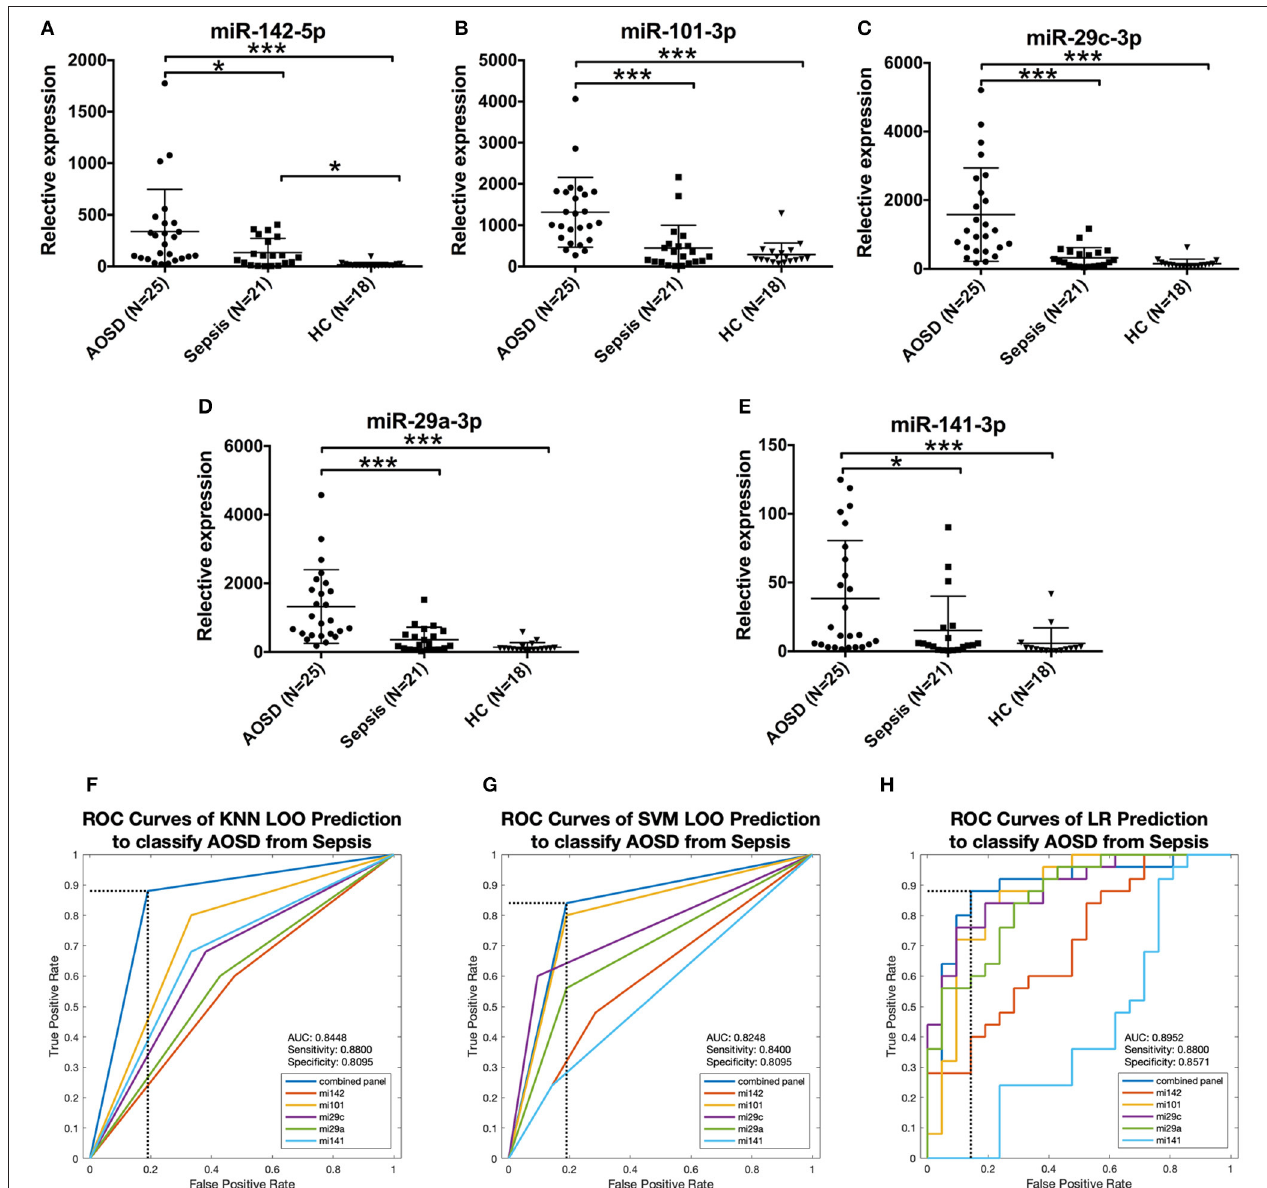
FIGURE 6 | Expression of AOSD miRNA signature in sepsis patients. Expression levels of (A) miR-142-5p, (B) miR-101-3p, (C) miR-29c-3p, (D) miR-29a-3p, (E) miR-141-3p were analyzed by analyzed by qRT-PCR in an independent set consisting of HC ( N = 18), AOSD ( N = 25) and sepsis ( N = 21) patients. The results of histograms represent the means ± SD, * P < 0.01, *** P < 0.001. (F-H) ROC analysis for individual miRNAs and combined miRNA panel was analyzed by KNN (F) , SVM (G) and LR (H) analysis. Logistic regression demonstrated that a linear combination of values for miR-142-5p, miR-101-3p, miR-29c-3p, and miR-141-3p produced the best model to distinguish AOSD patients from sepsis